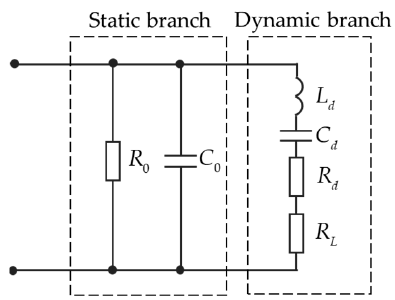
Figure 2. Equivalent circuit model of transducer.